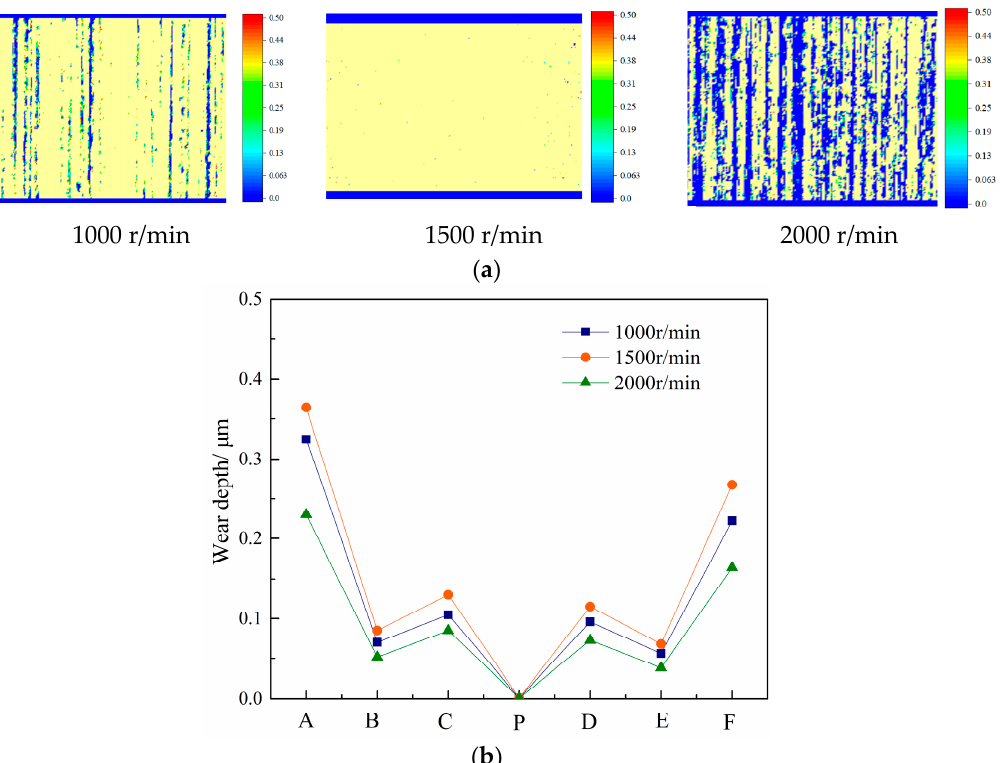
Figure 20. Wear depth at different rotating speeds. ( a ) Wear distribution. ( b ) Wear depth.